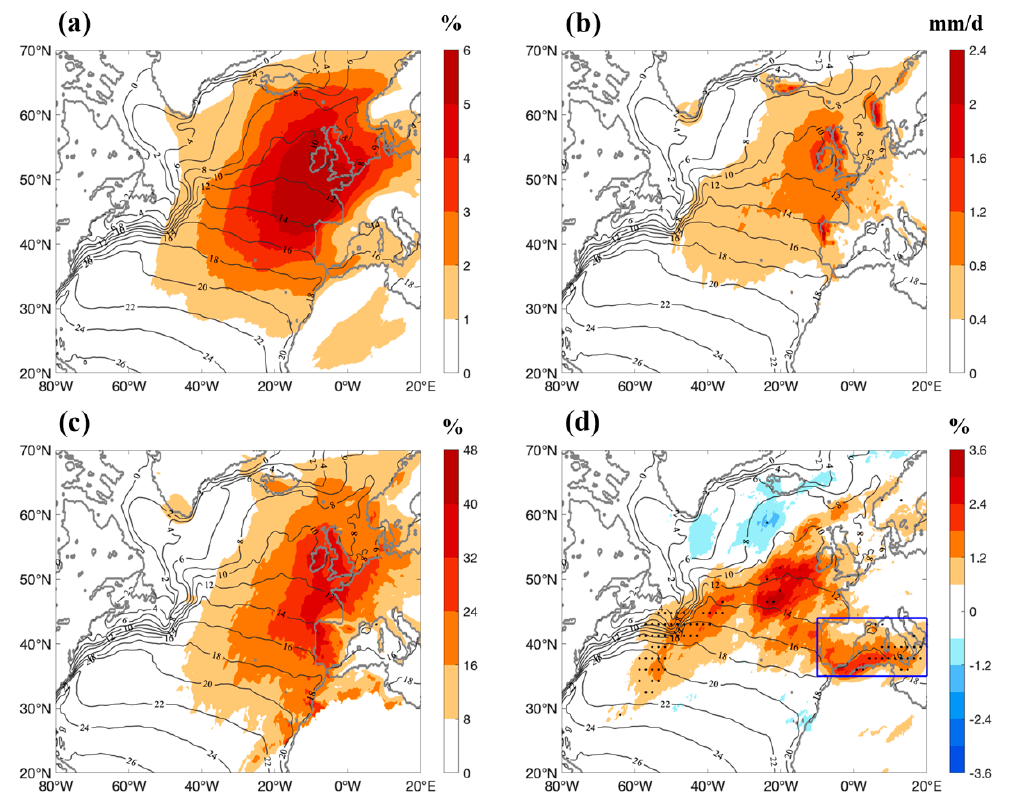
Figure 6. ( a ) Mean AR landfalling frequency during 1997–2019 (%). ( b ) As in ( a ) but for landfalling AR related rainfall (mm / d). ( c ) Ratio of landfalling AR-related precipitation to total precipitation (%). ( d ) Increase of landfalling AR frequency (%). Contours are mean SST between 1997 to 2019 ( ◦ C). Black dots mark the region in which the trend passed the 95% significance level. The blue box in ( d ) shows the region (10 ◦ W–20 ◦ E, 35 ◦ N–44 ◦ N) used to calculate the regional averaged precipitation in the Iberian Peninsula and the Mediterranean Sea region.